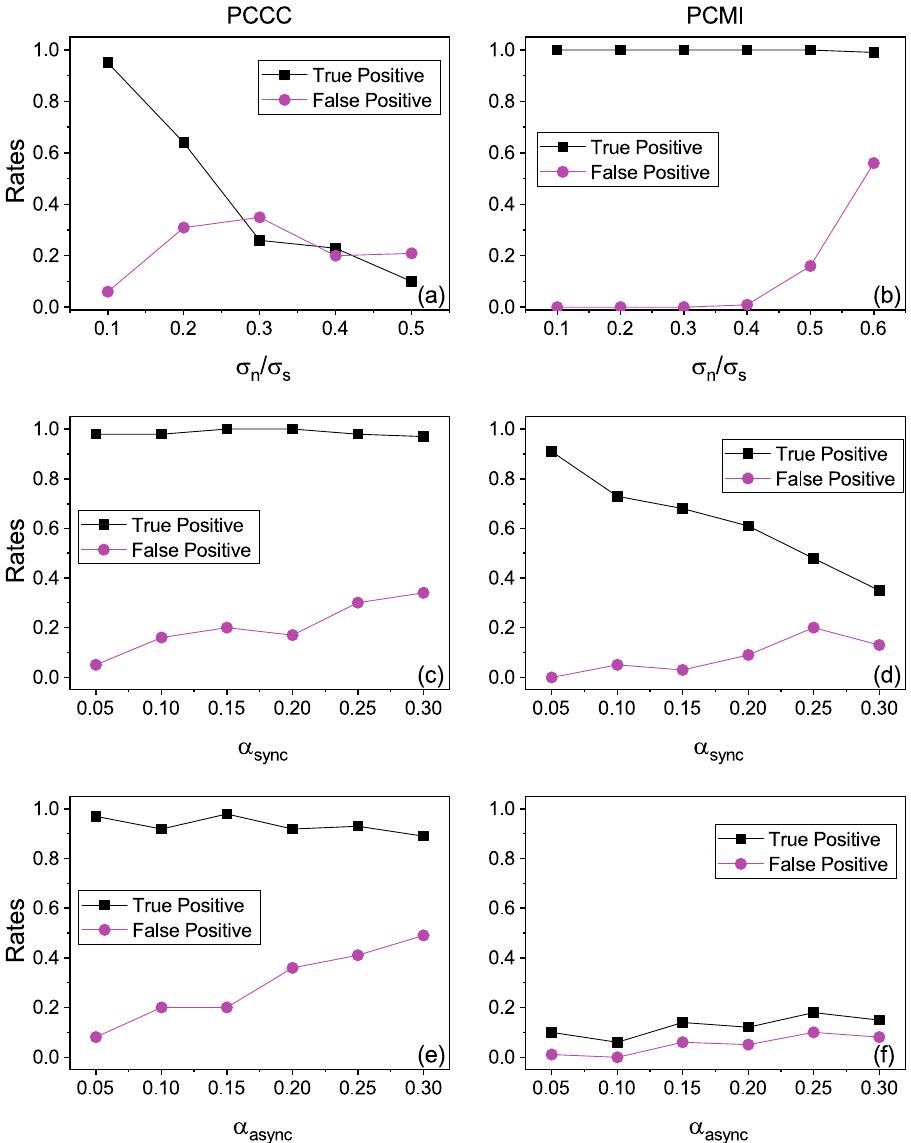
Figure 2. Specificity and sensitivity of methods with varying noise and sparsity. True positive rate (or rate of significant causality estimated from x 1 → x 2 ) and false positive rate (or rate of significant causality estimated from x 2 → x 1 ), using measures permutation CCC (PCCC) (left column) and permutation CMI (PCMI) (right column) as the level of noise: ( a , b ); level of synchronous sparsity: ( c , d ); and asynchronous sparsity: ( e , f ), are